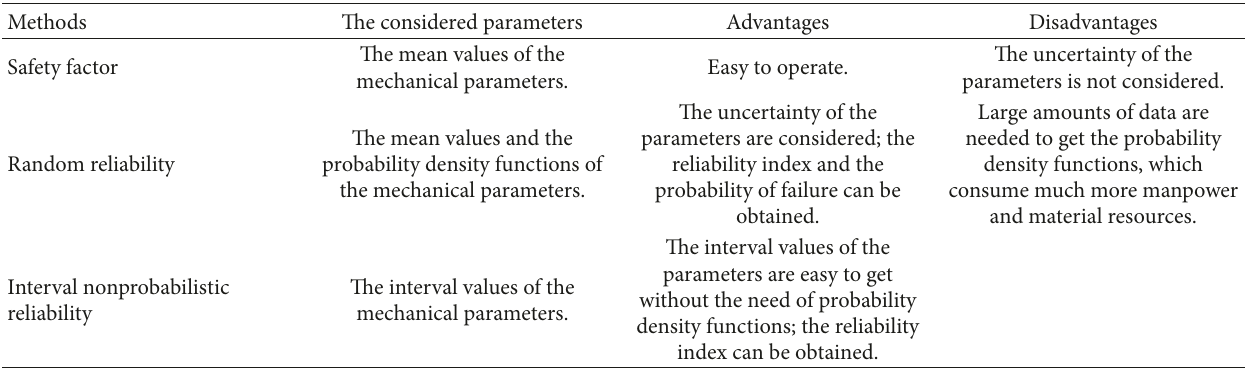
Table 5: The advantages and disadvantages of the safety factor, the random reliability, and the nonprobabilistic reliability. Methods The considered parameters Safety